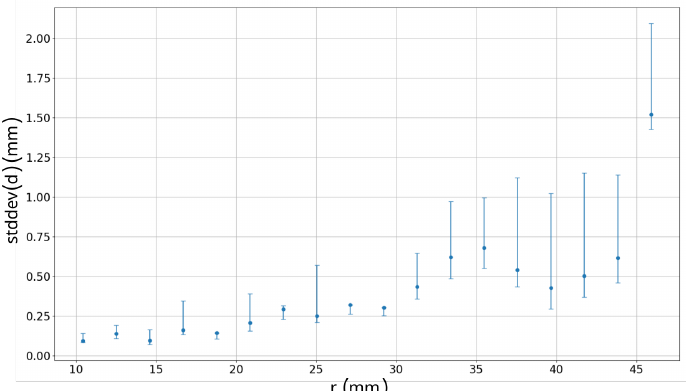
Figure 15. Results from visual analysis. X axis represents radius r . Y axis represents average standard deviation for all the weights with upper and lower error bands.